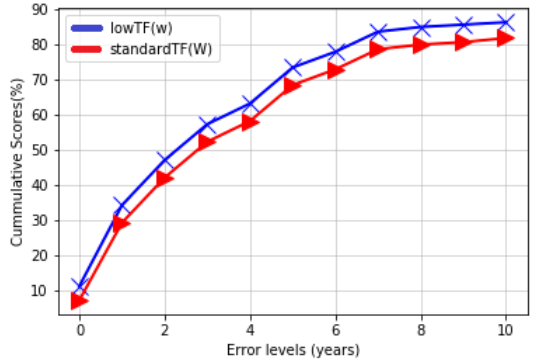
Figure 4. The effect of reduced TF.